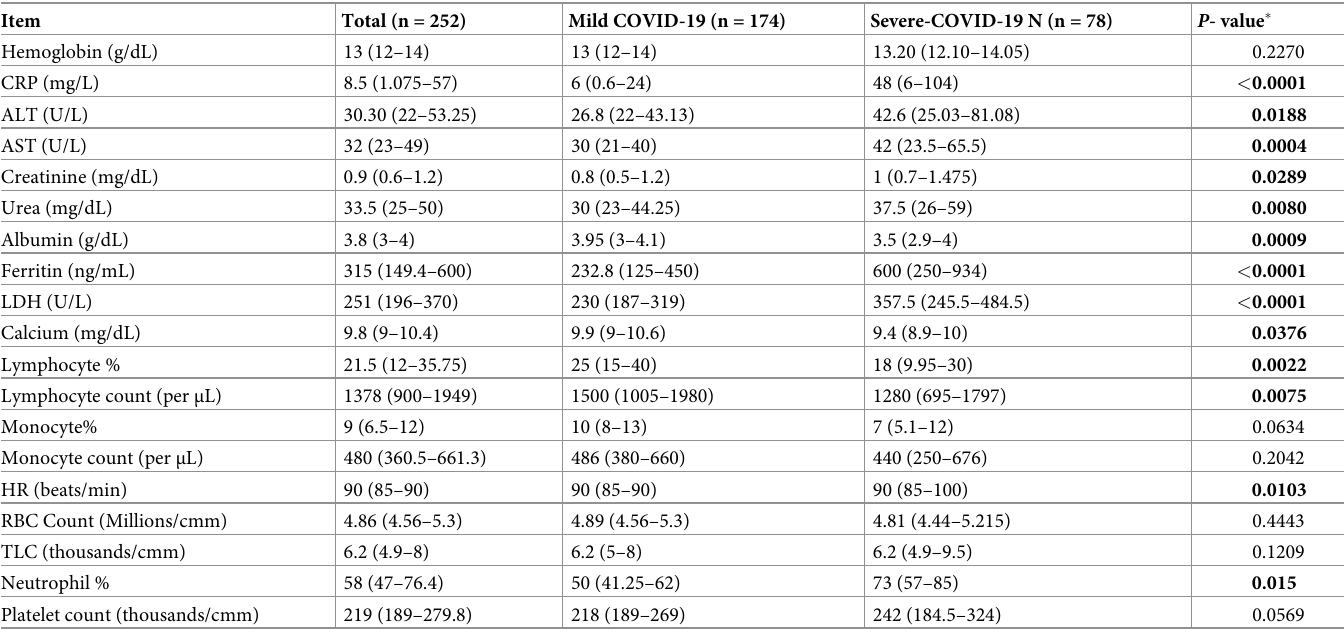
Table 2. Clinical laboratory data of patients included in the study.